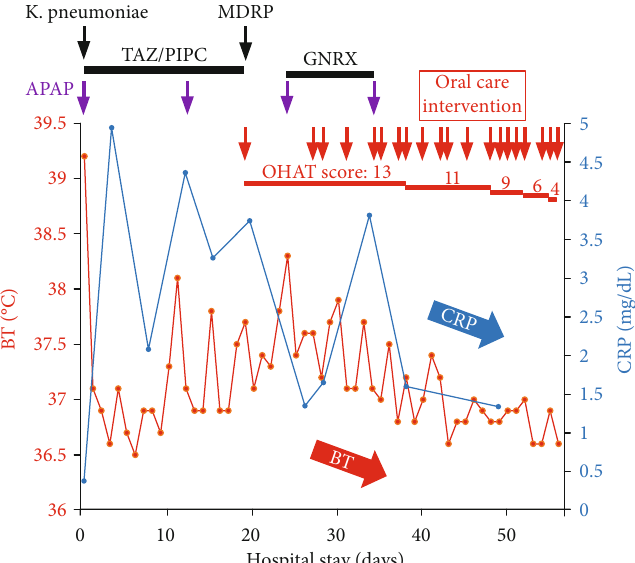
Figure 2: Time course of body temperature (BT) and C-reactive protein (CRP). BT and CRP are indicated by red closed circles and a solid line and blue closed circles and a solid line, respectively. Detection of bacteria by sputum culture, administration of acetaminophen (APAP), and professional oral health care intervention are indicated by black, purple, and red arrows, respectively. Treatment durations of tazobactam/piperacillin (TAZ/PIPC) and garenoxacin (GNRX) are indicated by solid bars. Oral Health Assessment Tool (OHAT) scores, assessed by the patient ’ s oral condition at each timepoint, are indicated by red colored and red underlined text in the upper part of the fi gure.